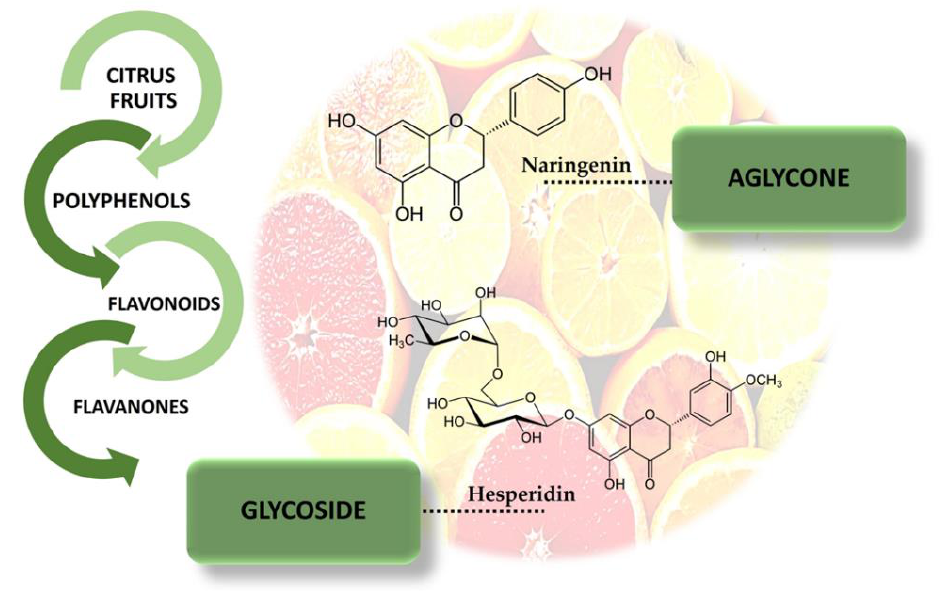
Figure 1. Naringenin and hesperidin derived from citrus fruits. Schematic representation of the sequential distribution of the major functional bioactive compounds (polyphenols, flavonoids, and flavanones) found in Citrus species and characterization of the molecular structure of the flavanone subclasses aglycone (naringenin) and glycoside (hesperidin). Of all the flavanone varieties, hesperidin (3,5,7-trihydroxyflavanone 7-rhamnoglucoside) and naringenin (4′,5,7 -trihydroxyflavanone) are the predominant flavanones in cit-